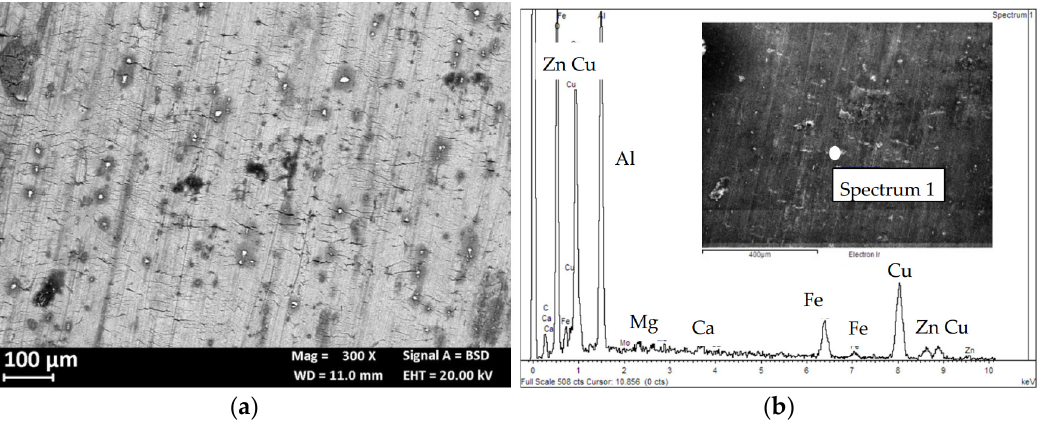
Figure 17. ( a ) Backscatter electron detector (BSD) image of the external surface of a base material specimen after the SSR test in NaCl 0.6 M, the bright zone indicates precipitates with higher atomic weight than the aluminum matrix; ( b ) EDX spectrum of one of these